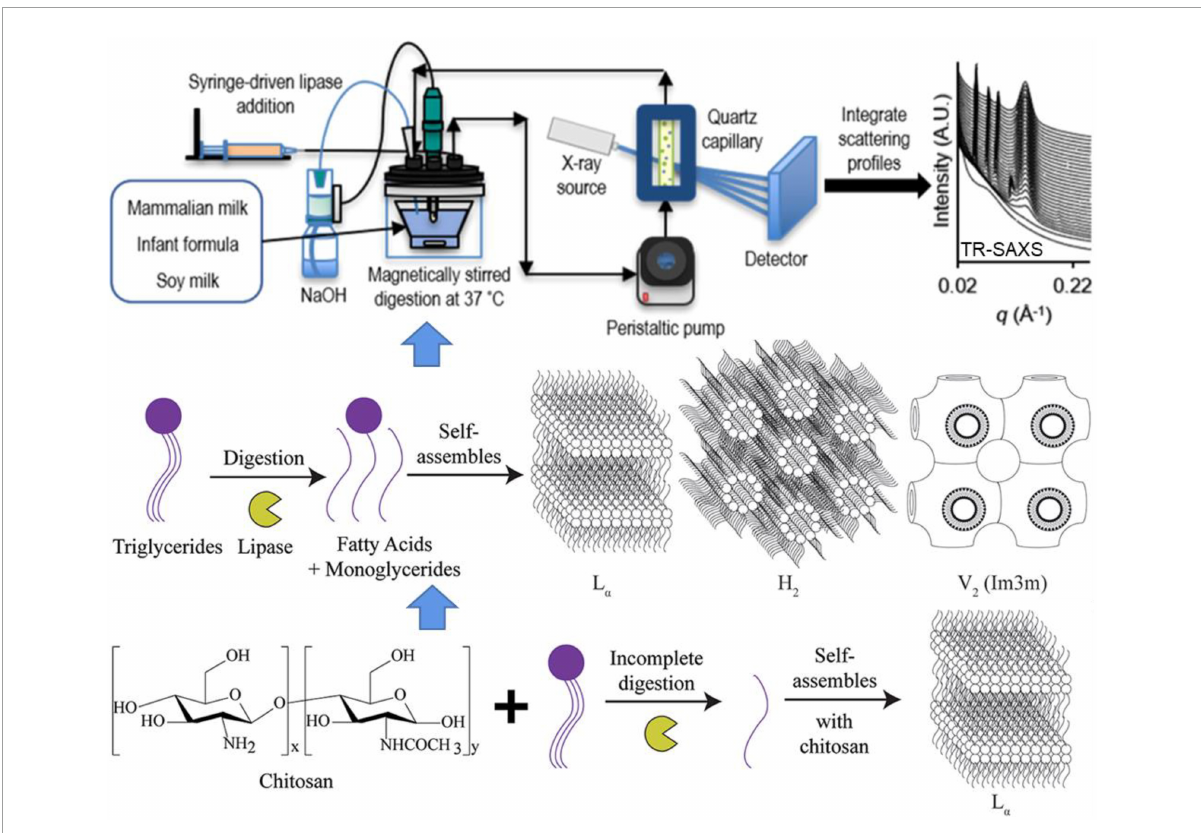
FIGURE8 Schematic diagram showing the detection of self-assembled structures of lipids during the digestion of milk using a lipolysis device coupled with in situ TR-SAXS. Reprinted from Pham et al.